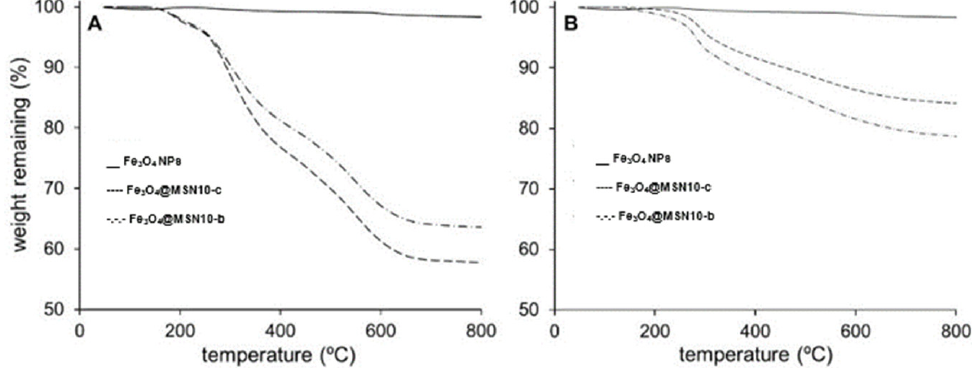
Figure 7. Thermal degradation of bare Fe 3 O 4 NPs and Fe 3 O 4 @MSNs samples, as made ( A ) and after the extraction of DSDA and FeNPs ( B ).